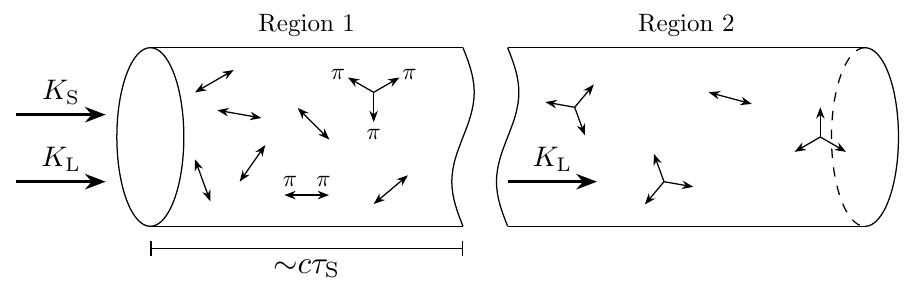
Figure 1 . Schematic view of the Cronin-Fitch